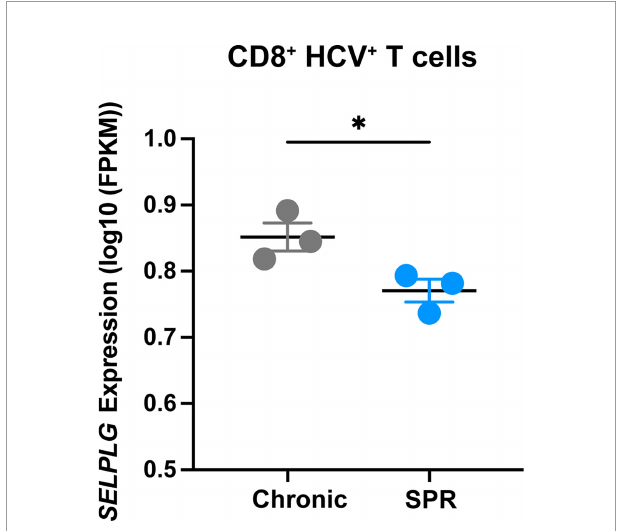
FIGURE 7 | SELPLG is upregulated in CD8 + T cells in patients with chronic HCV. Fragments per kilo base per million mapped reads (FPKMs) of SELPLG expression in HCV-speci fi c CD8 + T cells isolated from blood of chronically HCV infected patients or patients who spontaneously resolved their infection (SPR). *p < 0.05 (unpaired t -test). Each dot represents one patient (error bars,